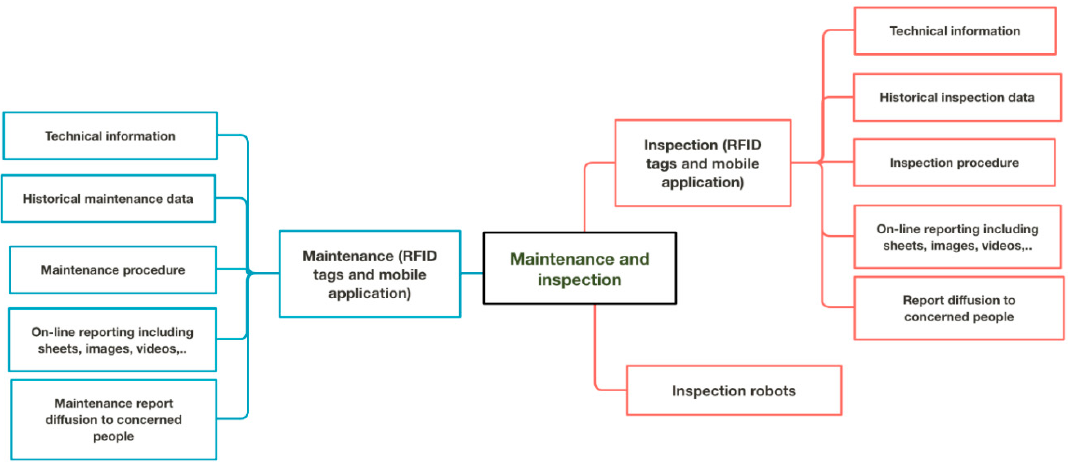
Figure 7. Inspection and maintenance data of the tunnel and hosted utilities.